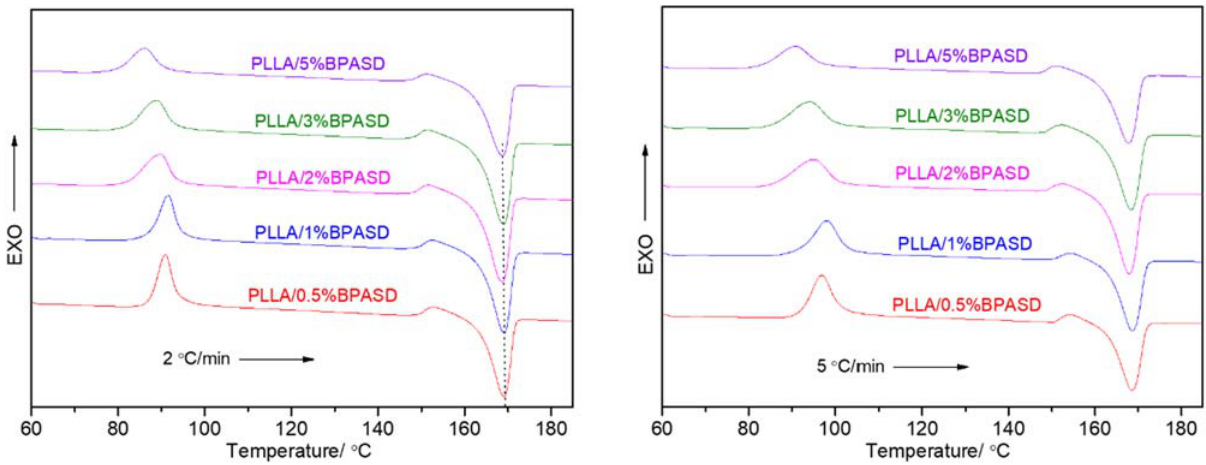
Figure 6: Cold - crystallization DSC curves of PLLA/BPASD samples at di ff erent heating rates.